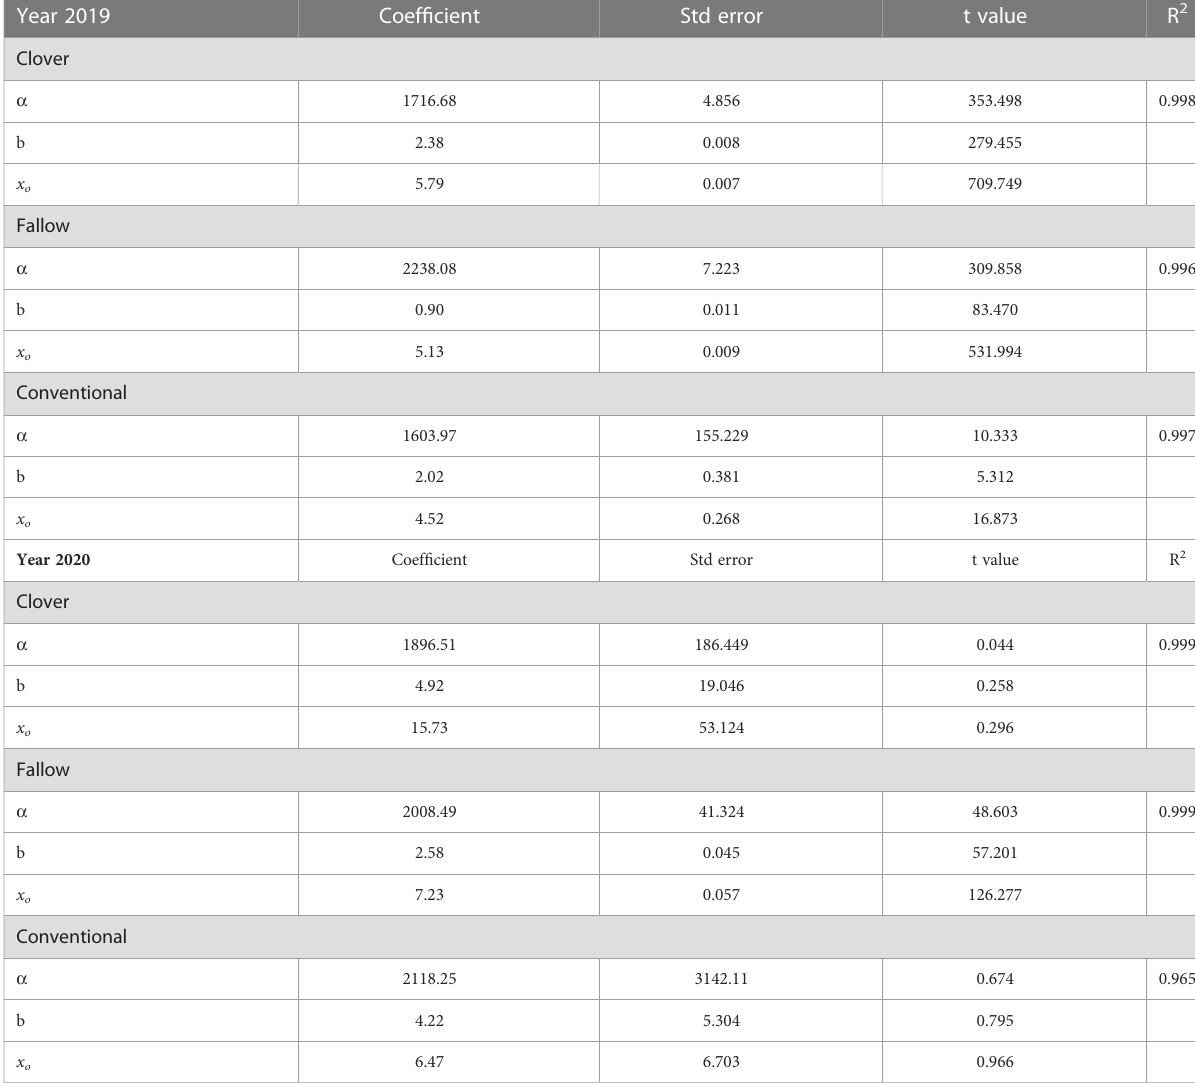
TABLE 4 Statistics for the three parameters Gompertz model used for fi tting weed biomass production under various weedy periods for each of the conservation tillage following a crimson clover cover crop (CT + CC), conservation tillage following winter fallow (CT + WF), and conventional tillage without a cover crop (CVT) treatment in 2019 and